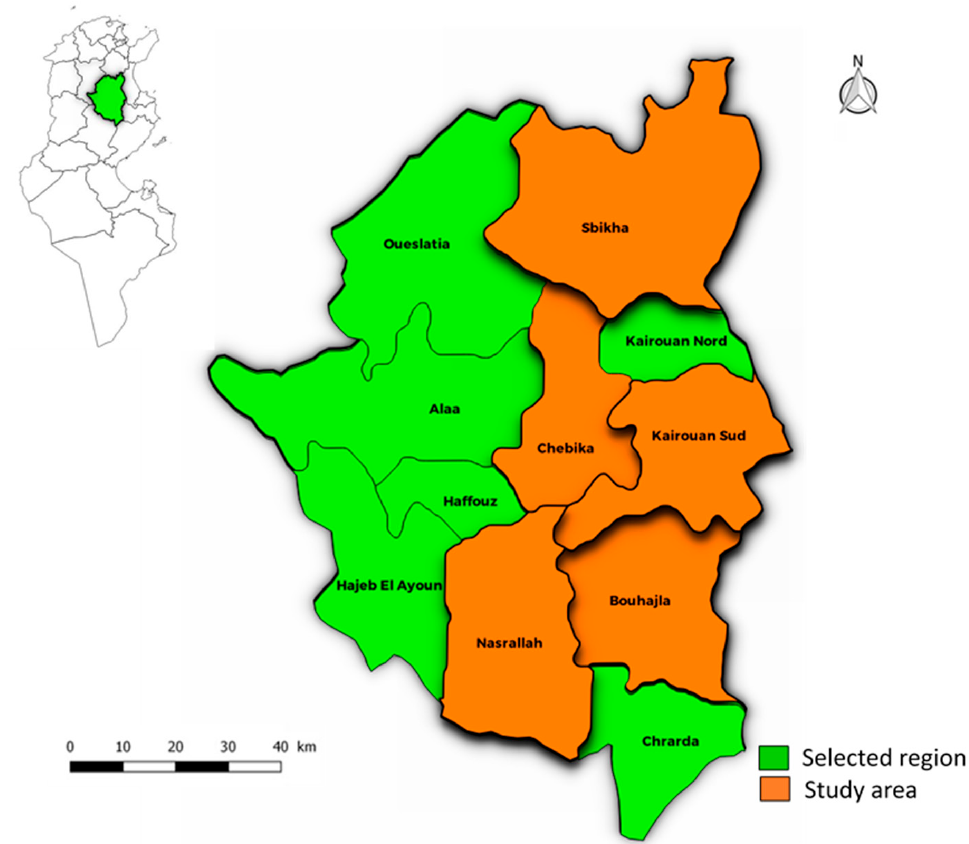
Figure 2. Location of the study area.